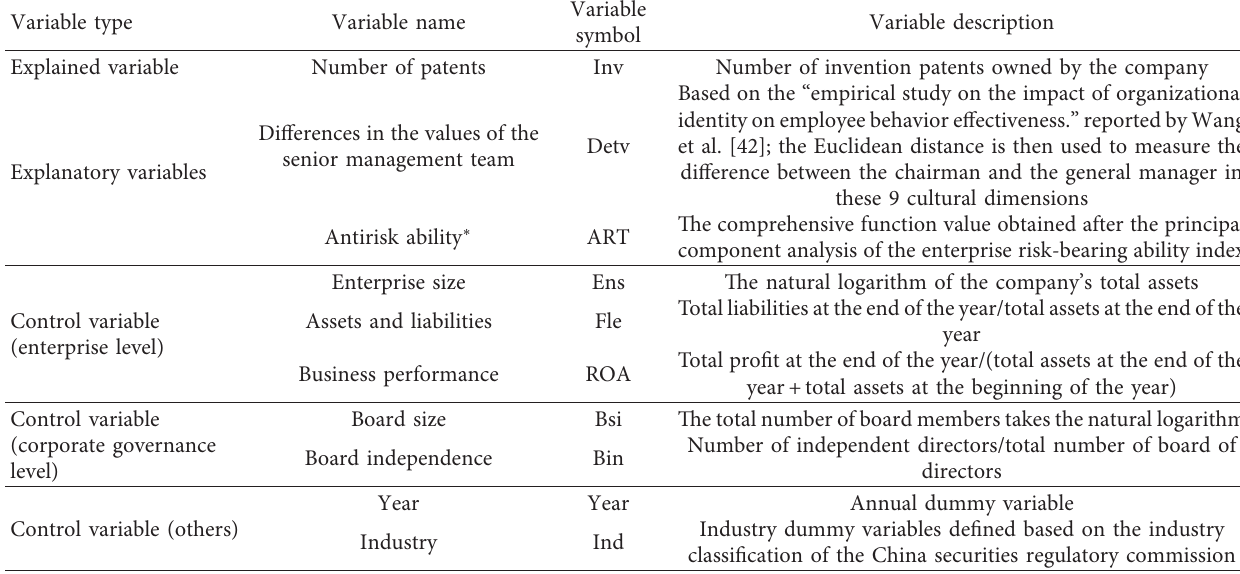
Table 1: Variable settings and definitions.